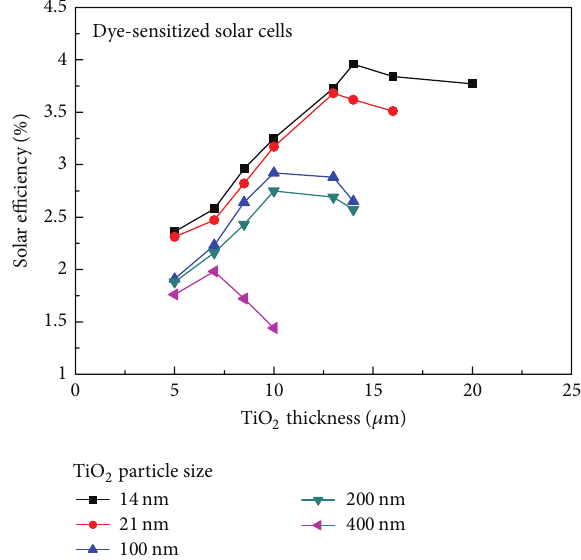
Figure 2: The solar efficiency dependence on the thickness of TiO 2 layers with different particle